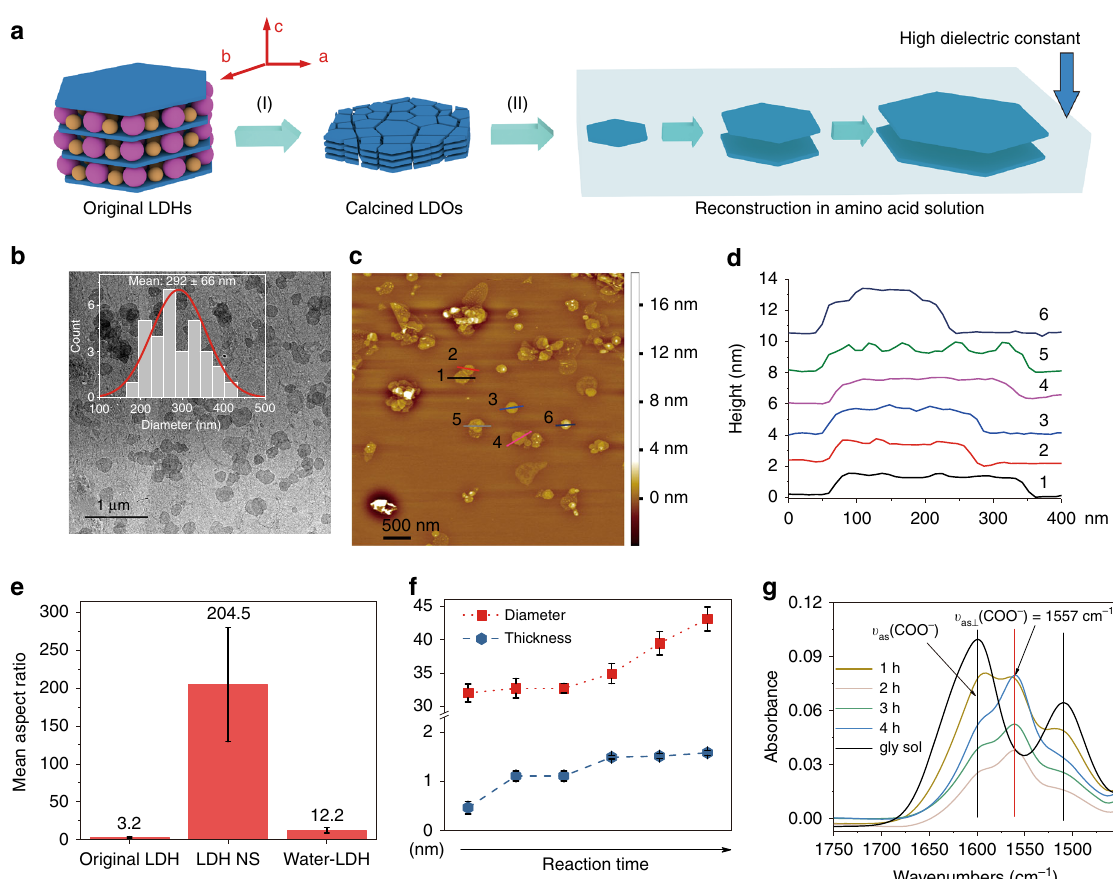
Fig. 1 High aspect ratio LDH nanosheets. a Schematic showing (I) calcination (interlayer water and anions are removed by calcination) and (II) reconstruction process and the preferential growth inhibition in a high dielectric constant solution: thickness growth is much slower than the diameter growth, giving high aspect ratio nanosheets. TEM image ( b ), AFM image ( c ) and height pro fi les ( d ) of the LDH NS reconstructed in glycine solution. The inset in TEM image represents the diameters measured by TEM. e Mean aspect ratio of the original LDH, LDH NS and control LDH reconstructed in water (Water-LDH). Aspect ratio was calculated by diameter divided by thickness of individual particles from AFM measurements of samples at more than three different spots. Error bar represents the standard deviation from more than 30 measurements. f Estimation of crystallite sizes calculated from Scherrer equation (Eq. (2)) con fi rming the signi fi cant growth inhibition along the c -axis. The red box with dotted line and the blue circle with dotted line represent the estimation of the diameter growth and thickness growth with reaction time. Error bar represents standard error in the curve fi tting. g IR spectra: formation of hydrogen bonding evidenced by a red shift of the asymmetric vibration of COO − group of glycine and that part of the group is shifted to orthogonal position ( ν as ⊥ (COO − ) = 1557 cm − 1 ) during reconstruction in glycine solution. The black lines are assigned to the asymmetric vibration of COO − group and the red line is attributed to the shift to orthogonal position of part of the group. Source data are provided as a Source Data fi